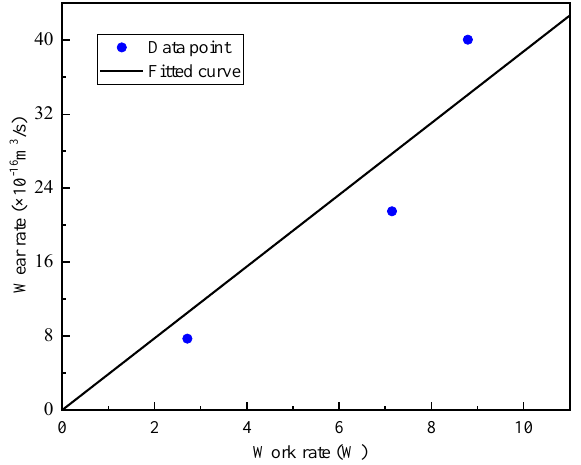
Figure 14. Wear rate and work rate of the tube.